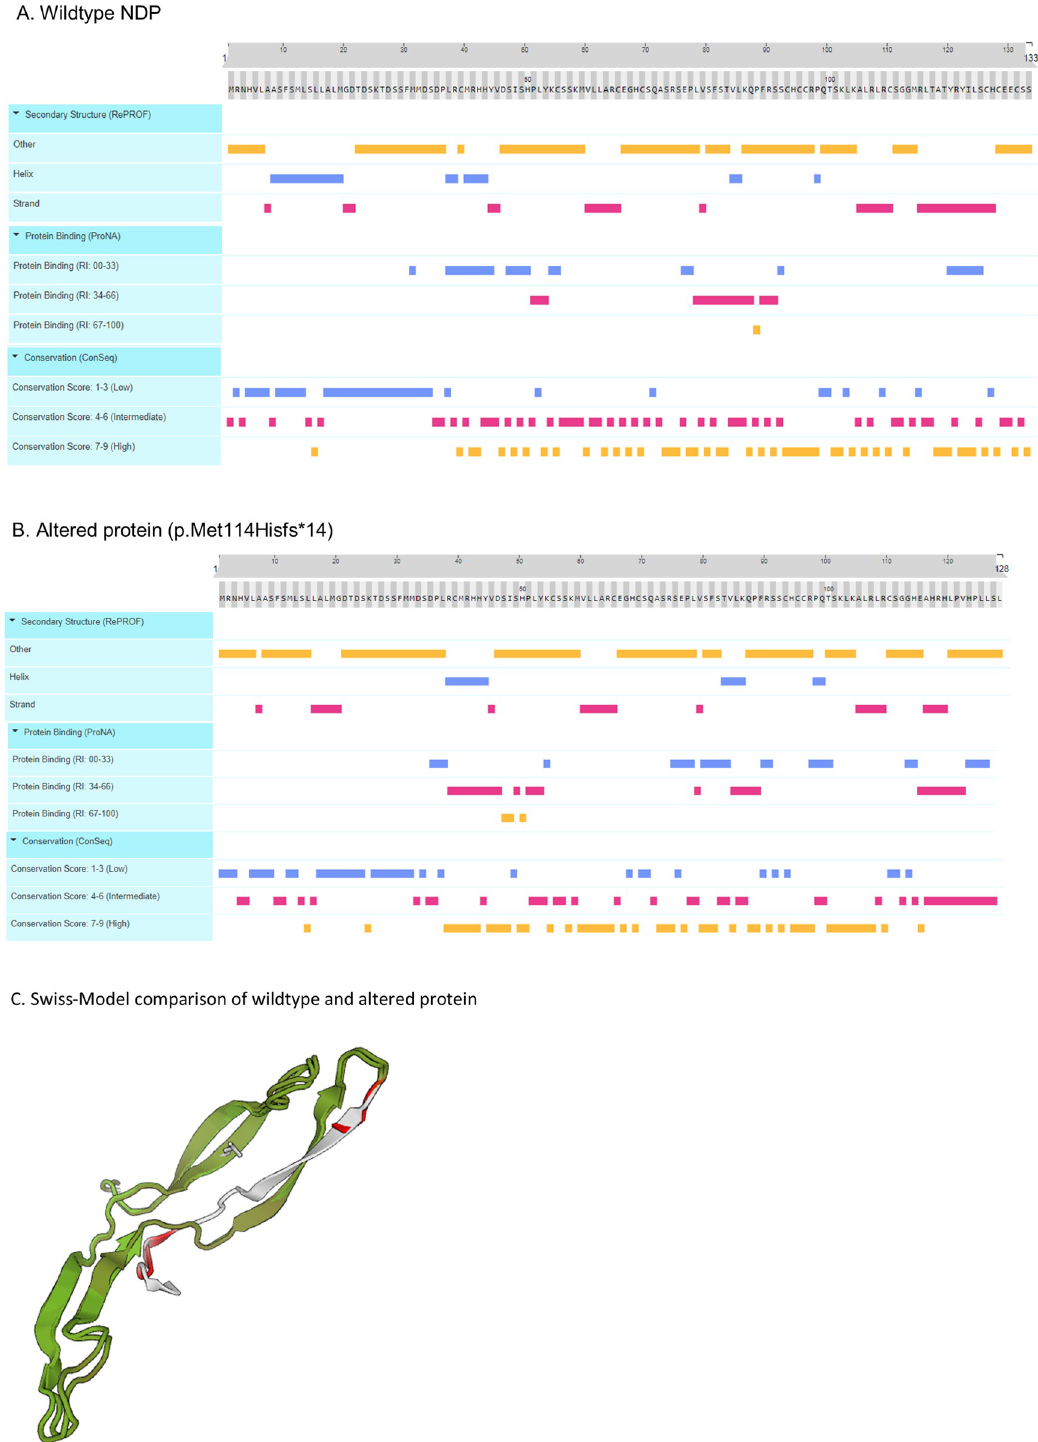
Fig 6. Comparison of the wildtype (A) and altered protein (B). Using PredictProtein reveal that the two proteins are expected to differ throughout with regards to secondary structure, protein binding and conservation. In addition, modelling of both proteins using Swiss-Model (C) reveal that in the altered molecule, the 15 amino acids at the C-terminus, involved in the shifted reading frame, do not align with the N-terminus (white and red in C) of the wildtype protein at all, and also do not align with any other known protein